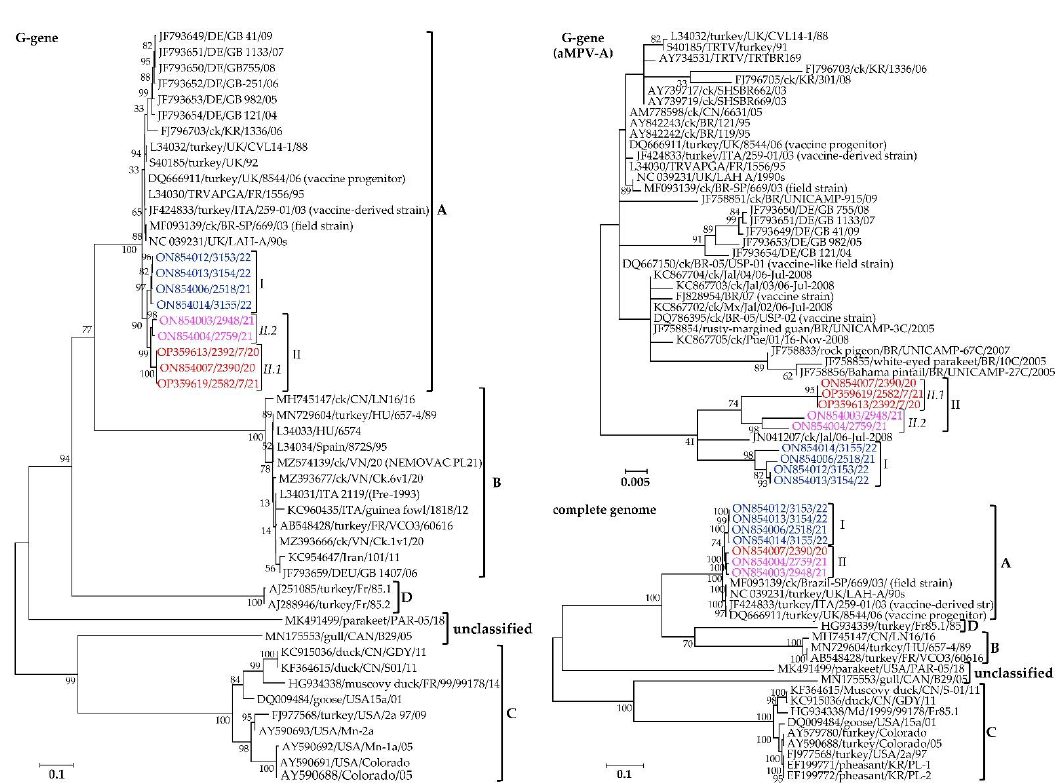
Figure 3. Relationships between the Mexican aMPV-A isolates identified in the current study (high- lighted in color) and previously reported aMPVs based on the attachment (G) gene and the full-length genome nt sequences. Isolate/strain names include GenBank accession number, avian spe- cies, country, and year of sample collection. Domain organization of the G-protein of the Mexican aMPVs is consistent with type II membrane proteins, consisting of an intracellular domain (aa residues 1 – 27), a trans- membrane domain (aa residues 28 – 53), and an ectodomain (residues 54 – 391); all the se- quences have 19 conserved cysteine residues (Figure 4), which is consistent with other previously reported aMPV-A strains [2]. Multiple alignments of the deduced that the aa sequence of the G-proteins concurred with the phylogenetic clustering of the Mexican iso- lates, with 38 aa variations amongst clusters I, II.1, and II.2, and when compared to strains LAH-A/90s, BR-SP/669/03 and 8544/06 (Figure 4). One of the aa variations occurs in a con- served stretch of 25-aa residues within the ectodomain (residues 124 – 148 as reported in other aMPV-A and -B viruses [2]) where the Mexican aMPVs have adenine at position 133 (A133) compared to V133 in other aMPV-A viruses. The A133 is present in the G-protein sequences of aMPV-B viruses such as the French strain AJ251085/turkey/Fr/85.1 and the Italian strain L34031/TRVAPGB/ITA-2119 [2]. Another difference is the presence of seven potential N -linked glycosylation sites in the Mexican aMPVs compared to five sites in other aMPV-A strains.